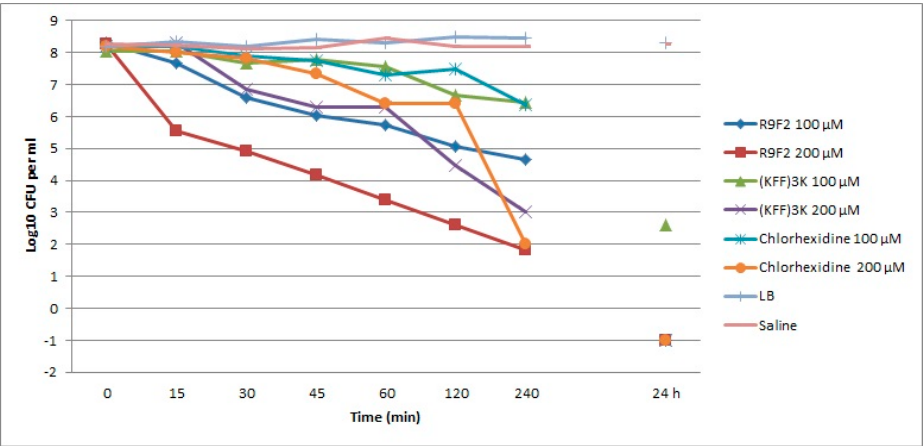
Figure 1. Viability of S. aureus in the presence of R9F2 and (KFF)3K peptides and chlorhexidine. Viability of S. aureus in 0.9% NaCl solution (saline) and LB broth is presented as a negative control.